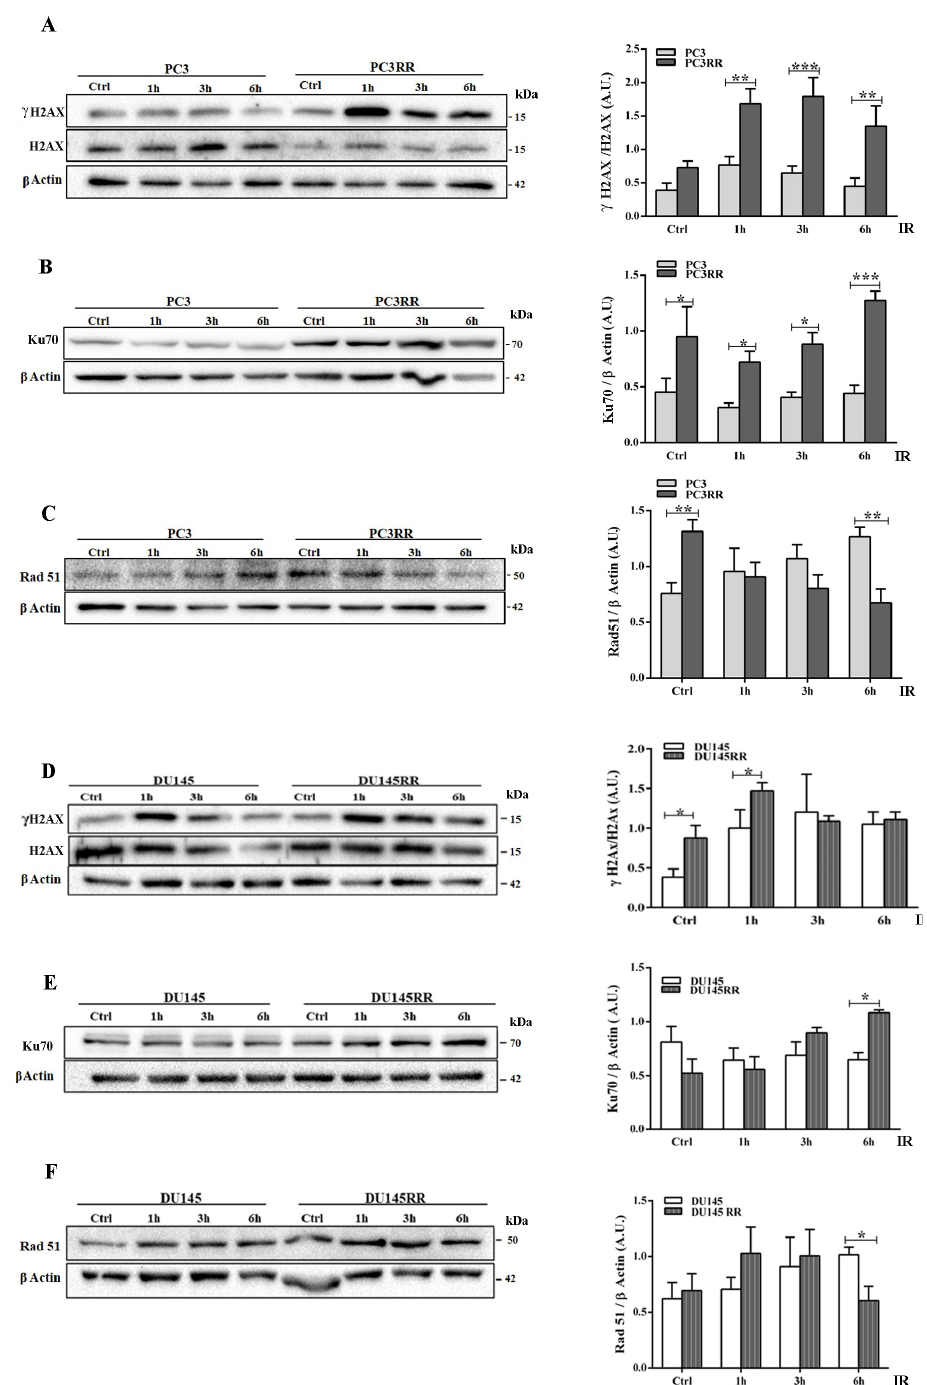
Figure 3. Different DNA repair mechanisms activated by IR in PC3RR and DU-145RR cells compared to their parental counterparts. Cell lysates from unirradiated cells (Ctrl) or cells irradiated with 4 Gy were collected at the indicated times after IR and analysed with Western blot by using specific antibodies against γ H2AX/H2AX ( A , D ), Ku70 ( B , E ) and Rad51 ( C , F ). β -Actin or α -Tubulin were used as controls for equal amounts of loaded proteins. Each blot is representative of at least three. The histograms represent the densitometric analysis of Western blot experiments evaluated as arbitrary units (A.U.). Data represent the mean ± S.E.M. derived from at least three independent experiments. Statistical significance: * p < 0.05; ** p < 0.01; *** p < 0.001; PC3RR vs. PC3 and DU-145RR vs. DU-145 Student’s unpaired t -test. The whole Western blots were shown in File